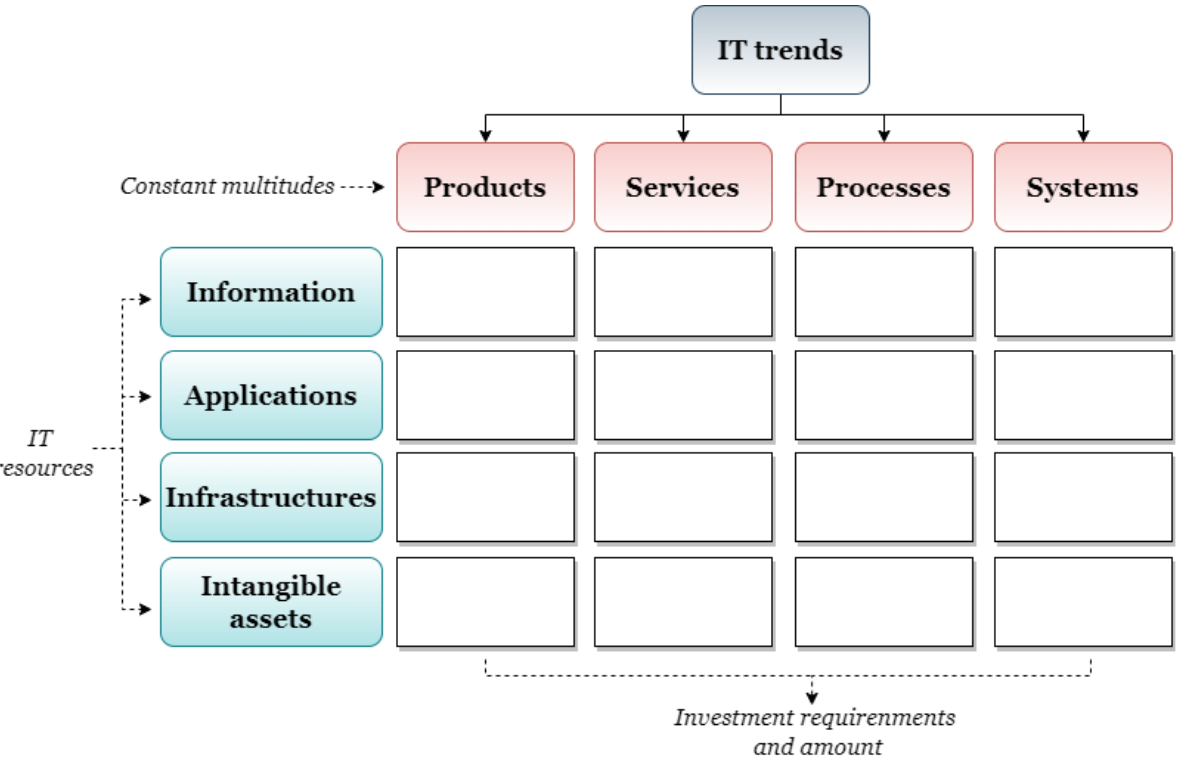
Figure 2. The conceptual model (matrix) for assessing the investments in the necessary IT re-